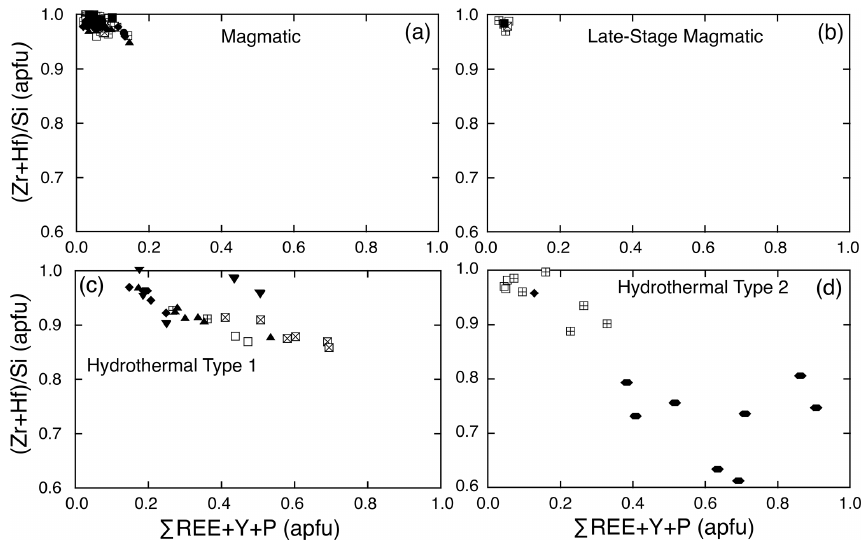
Figure 4. Deviation from ideal ZrSiO 4 by trace-element ( (cid:54) REE + Y + P) substitutions in the studied zircons: (a) magmatic, (b) late-stage magmatic, (c) hydrothermal type 1, and (d) hydrothermal type